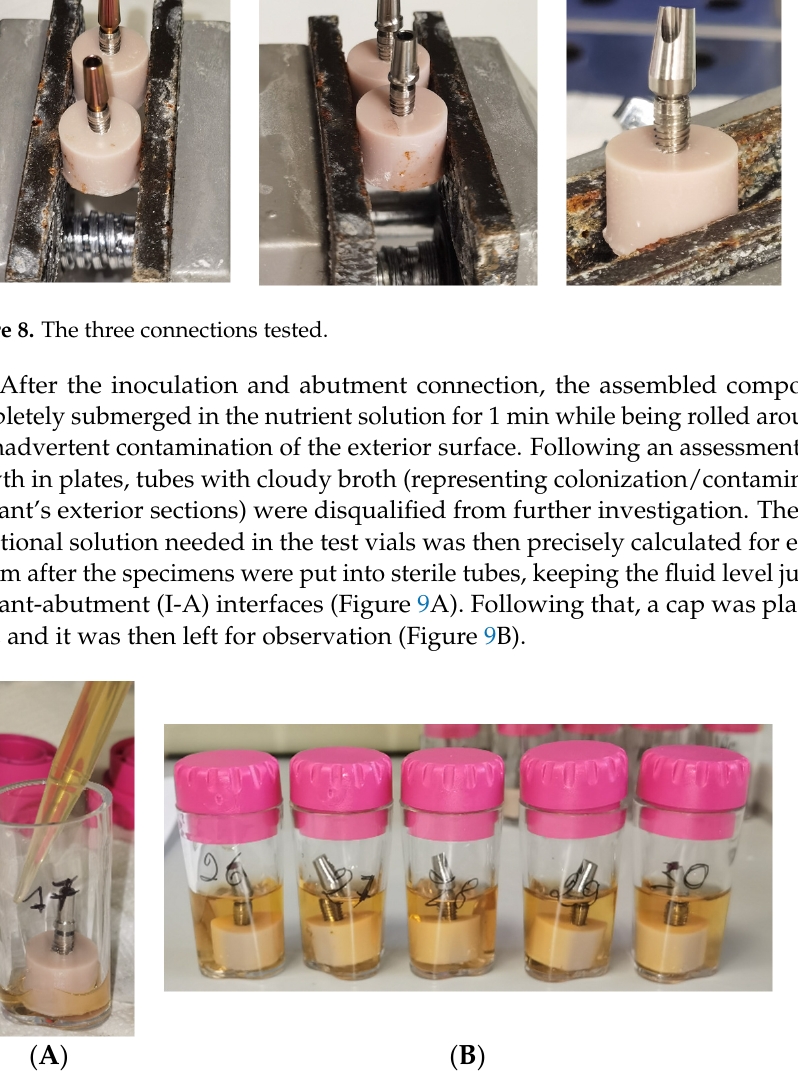
Figure 8. The three connections tested.